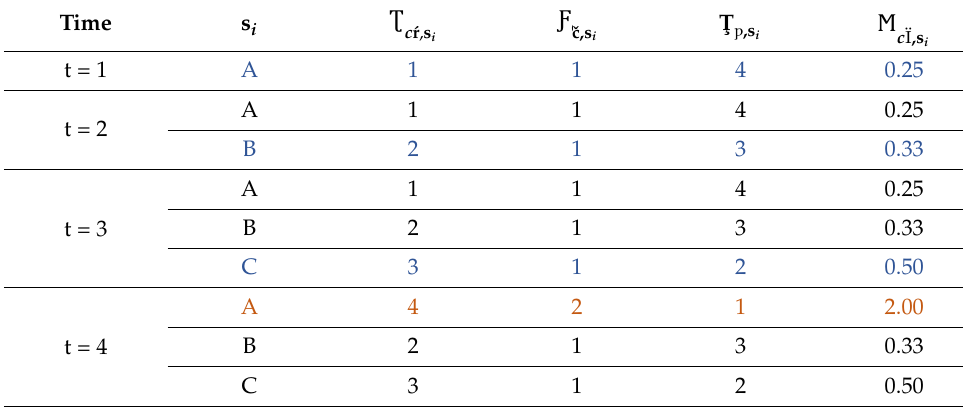
Table 2. IMU process at t = 1 to t = 4. Time